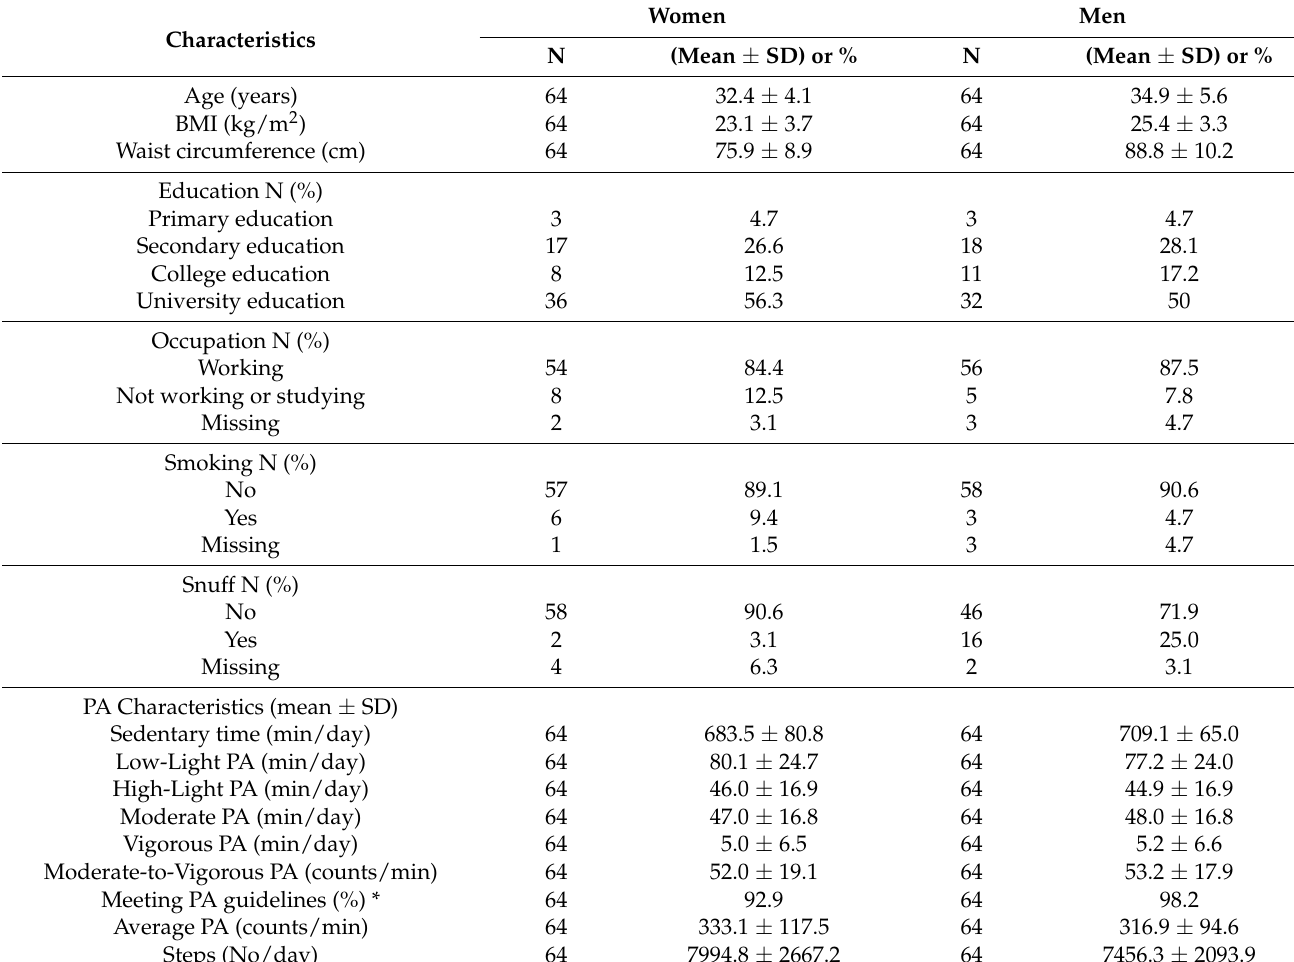
Table 1. Distribution of demographic and physical and sedentary activity characteristics of infertile couples.